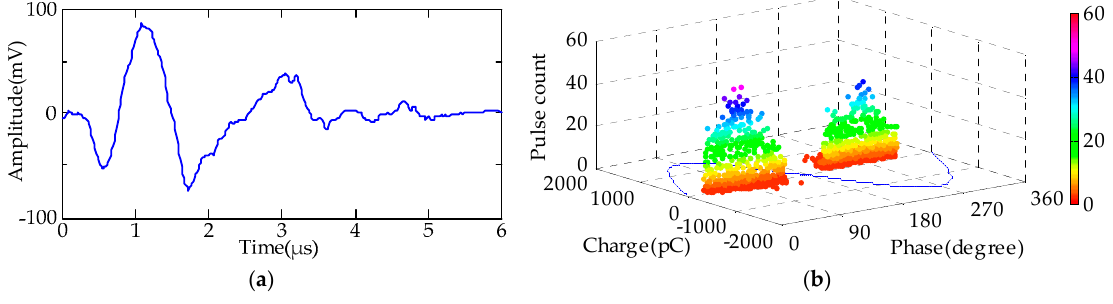
Figure 9. PD data patterns ( a ) PD pulse waveform; ( b ) PD PRPD pattern.